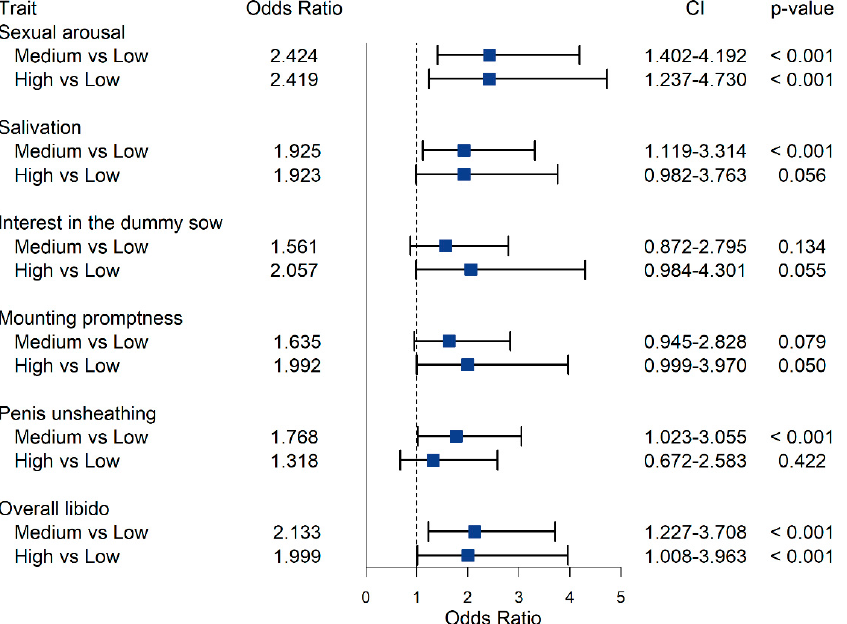
Figure 5. Odds ratio for the effect of average and high indole concentration in subcutaneous adipose tissue, compared to low indole concentration, on sexual behavior traits evaluated during the third training session. The dashed line corresponds to an odds ratio equal to 1.00.